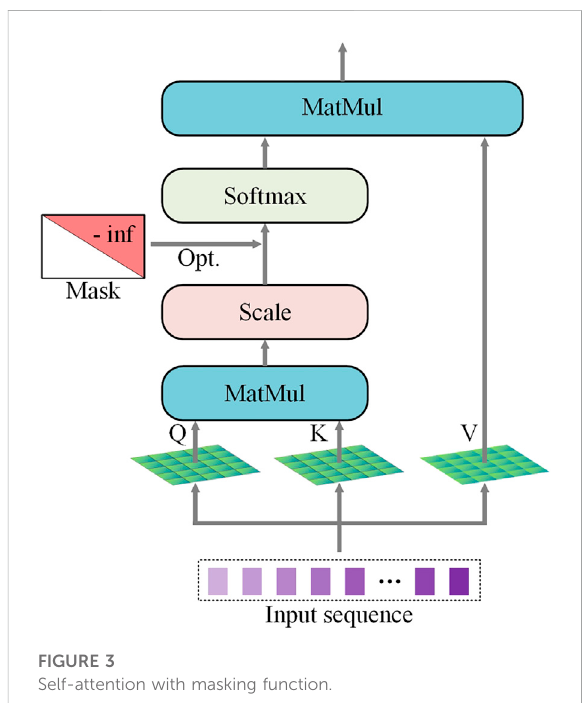
FIGURE 3 Self-attention with masking